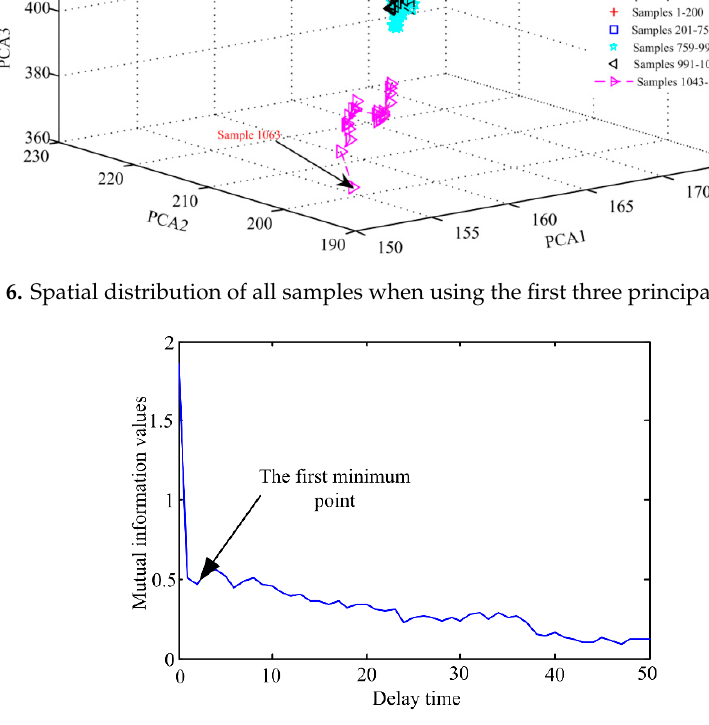
Figure 7. Selection of the delay time by the average mutual information method.